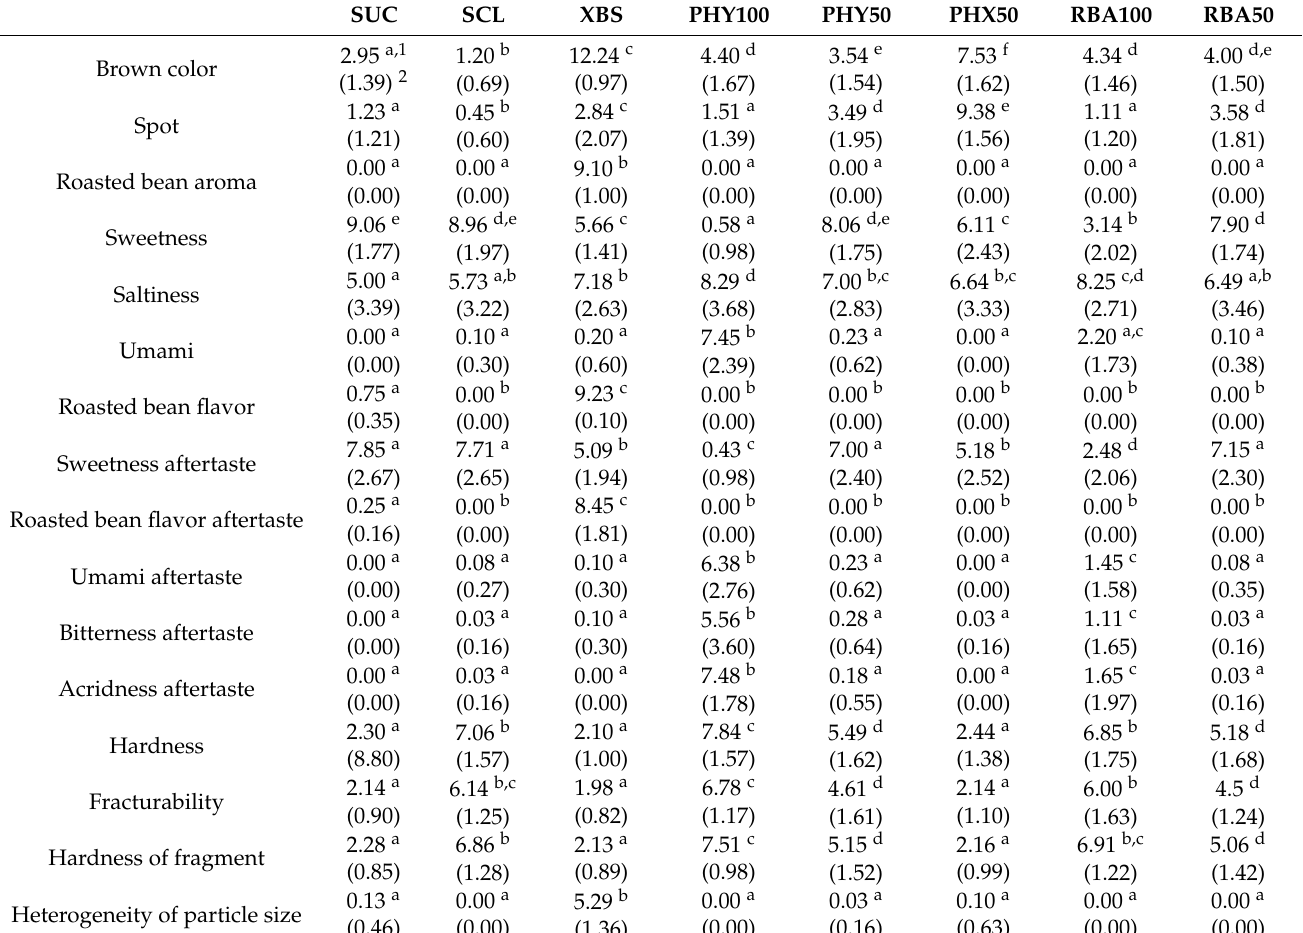
Table 4. Mean intensities of descriptive sensory attributes elicited by eight sweetener cookies.